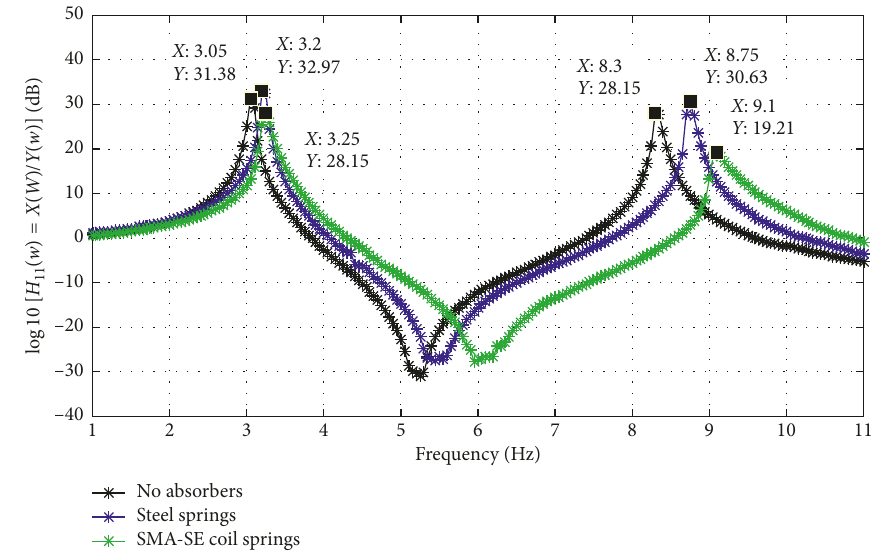
Figure 15: Experimental FRF of the first floor of the